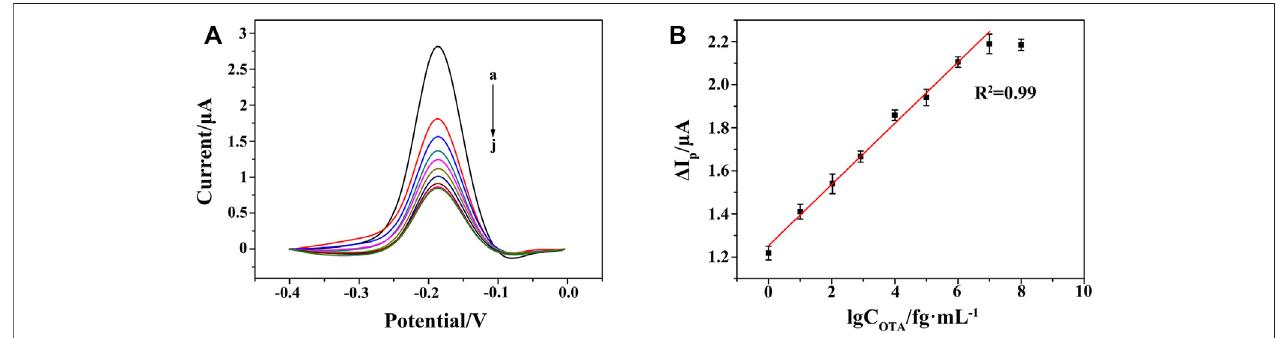
FIGURE7|(A) DPVresponsesattheHCR/ssDNA/HP1/AuNPs/ZIF-8/ITOwithvaryingconcentrationsofOTAfrom0to10 7 fgml − 1 (curvesatoj:0,1 fgml − 1 ,10 fg of OTA concentration from 1 to 10 7 fg ml − 1